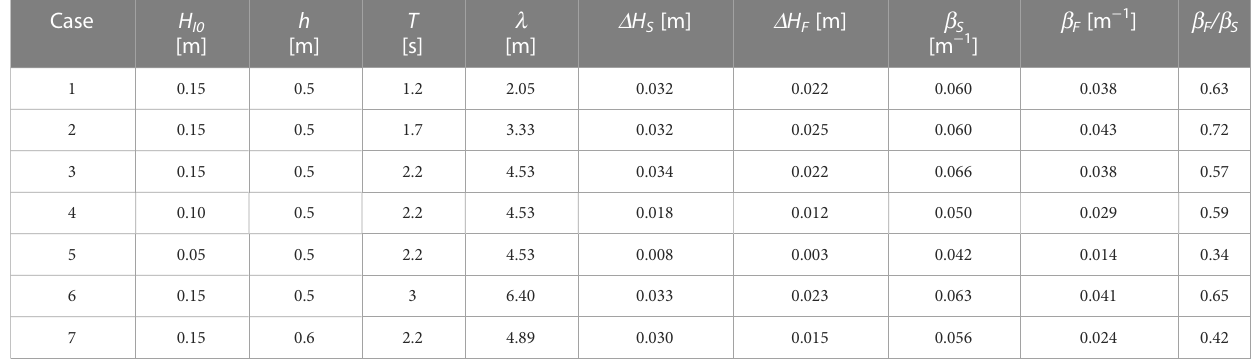
Measurements for the damping coef fi cients of standing ( b S ) and fl attened ( b F ) vegetation.